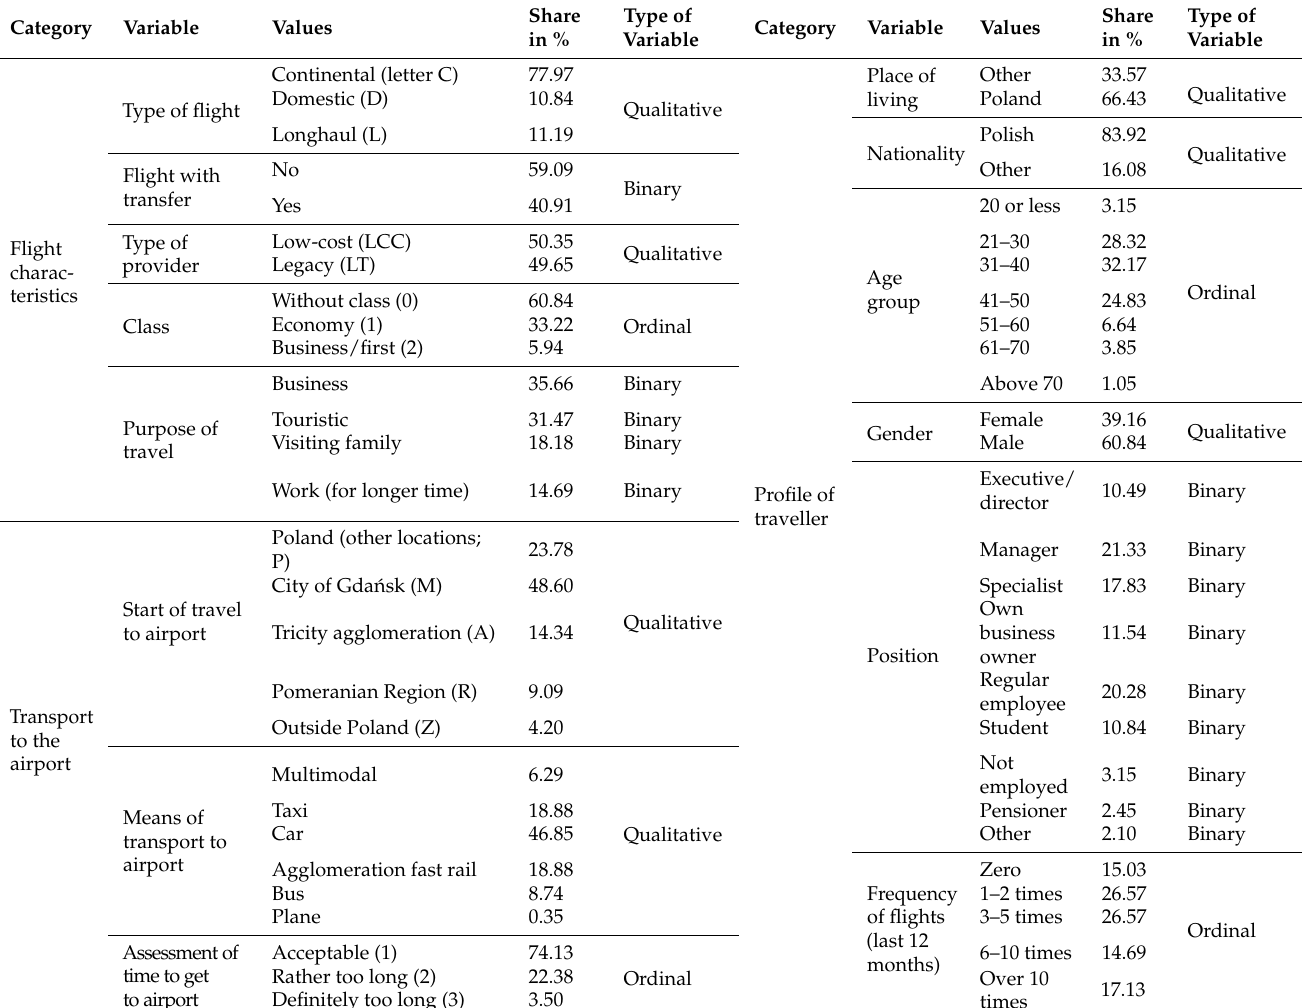
Table 1. Descriptive statistics for the surveyed